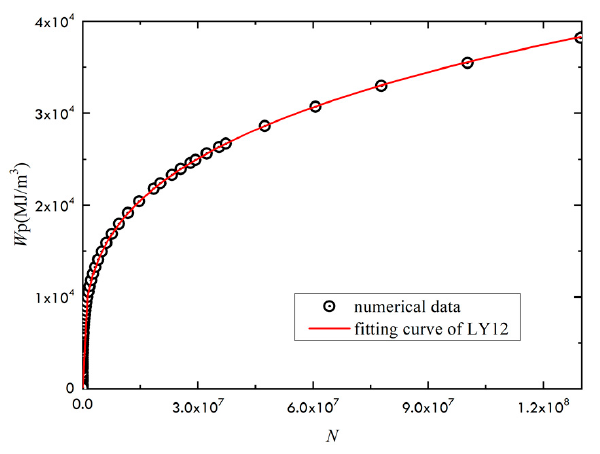
Figure 4. Relation between the accumulated plastic strain energy density and fatigue life of LY12.